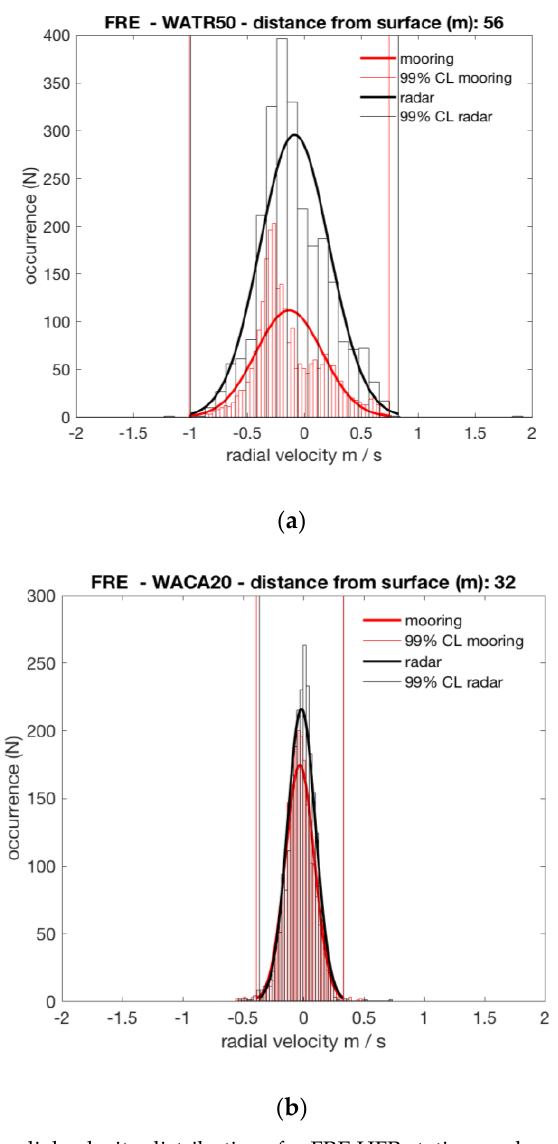
Figure 2. Examples of radial velocity distributions for FRE HFR station, and corresponding subsurface radial velocity components, at two deep-water mooring locations within the radar domain: ( a ) 56 m from the surface; ( b ) 32 m from the surface. Units for radial velocity are m/s.